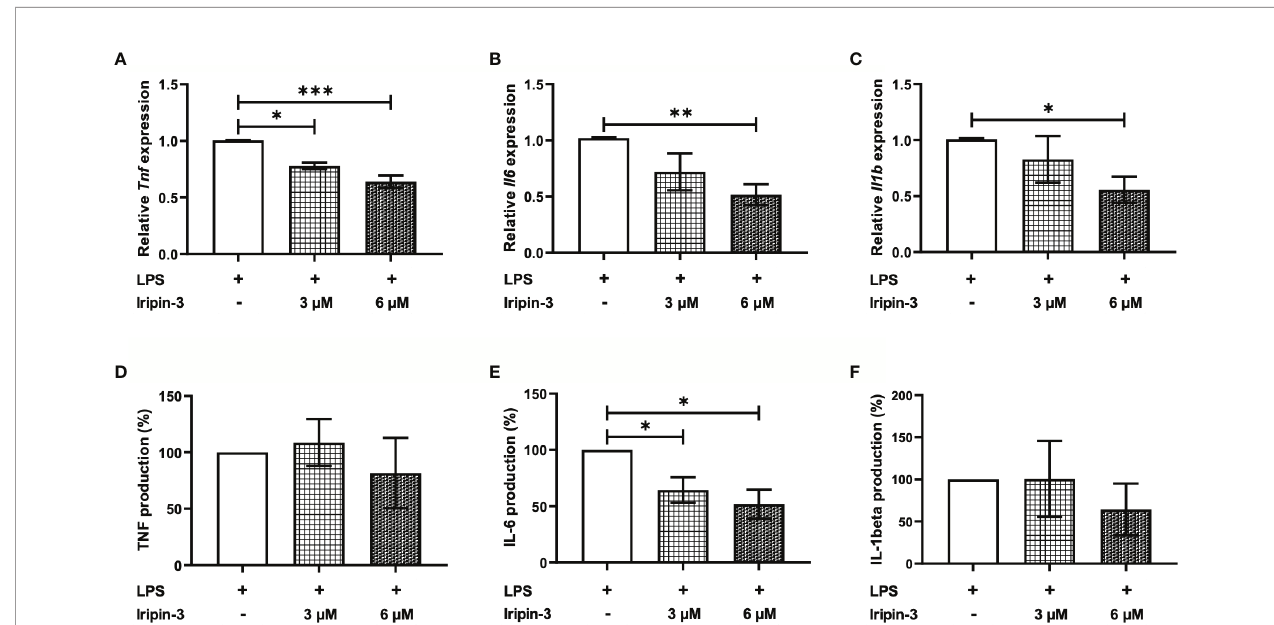
FIGURE 7 | Iripin-3 inhibits the expression of pro-in fl ammatory cytokines in LPS-stimulated BMDMs. Macrophages derived from bone marrow cells isolated from C57BL/6N mice were pre-incubated with 3 m M or 6 m M Iripin-3 for 40 min and were then stimulated with LPS (100 ng/ml) for 24 h. (A – C) At the end of 24 h incubation, cells were harvested for RNA extraction and the expression of Tnf (A) , Il6 (B) , and Il1b (C) was determined by RT-qPCR. Relative expression values were calculated using the delta-delta Ct (Livak) method (60), with Gapdh serving as a reference gene. Cells incubated only in the presence of LPS were utilized as a calibrator during calculations. Data are presented as mean ± SEM of four independent experiments (*p < 0.05, **p < 0.01, ***p < 0.001). (D – F) Supernatants were collected, and TNF, IL-6, and IL-1 b concentrations in these supernatants were measured by sandwich ELISA. TNF (D) , IL-6 (E) , and IL-1 b (F) production by Iripin-3- treated BMDMs is expressed as the percentage of the cytokine production by control macrophages, since there were large differences in the concentrations of the same cytokine between three independent repeats of the experiment. Data are expressed as mean ± SEM, and statistically signi fi cant differences (p < 0.05) are marked with an